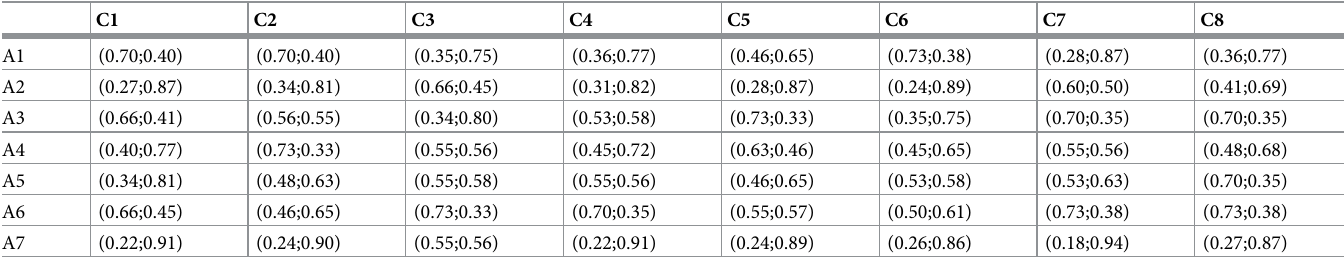
Table 3. Pythagorean fuzzy alternative assessment